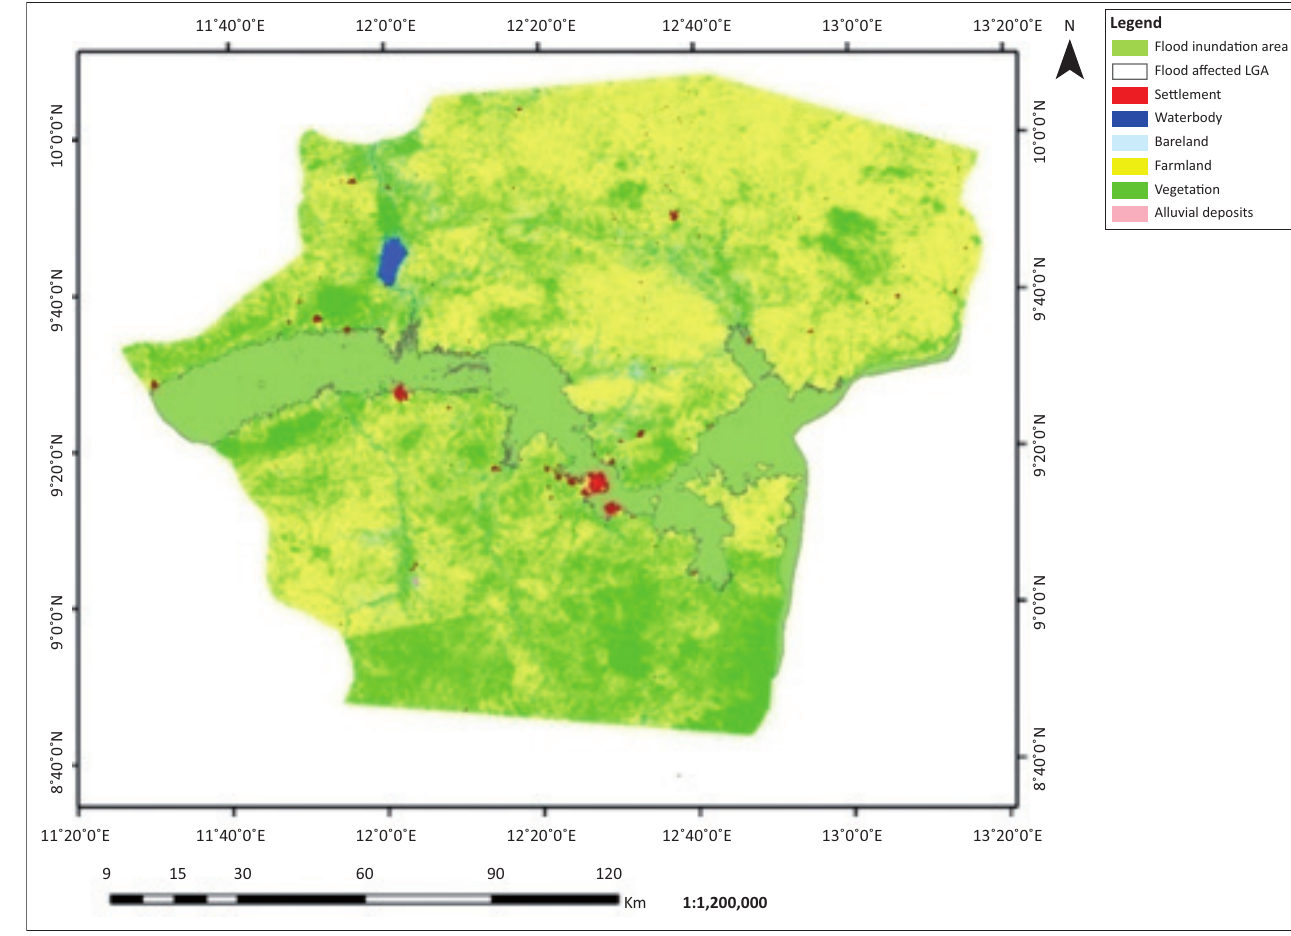
FIGURE 3: Flood inundation and land use and/or land cover map of Adamawa